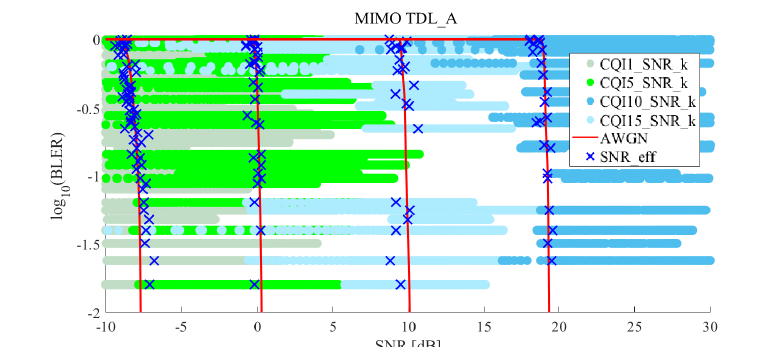
Figure 9. Effective SNR mapping results of the proposed ML-based EESM method under 5G TDL-A